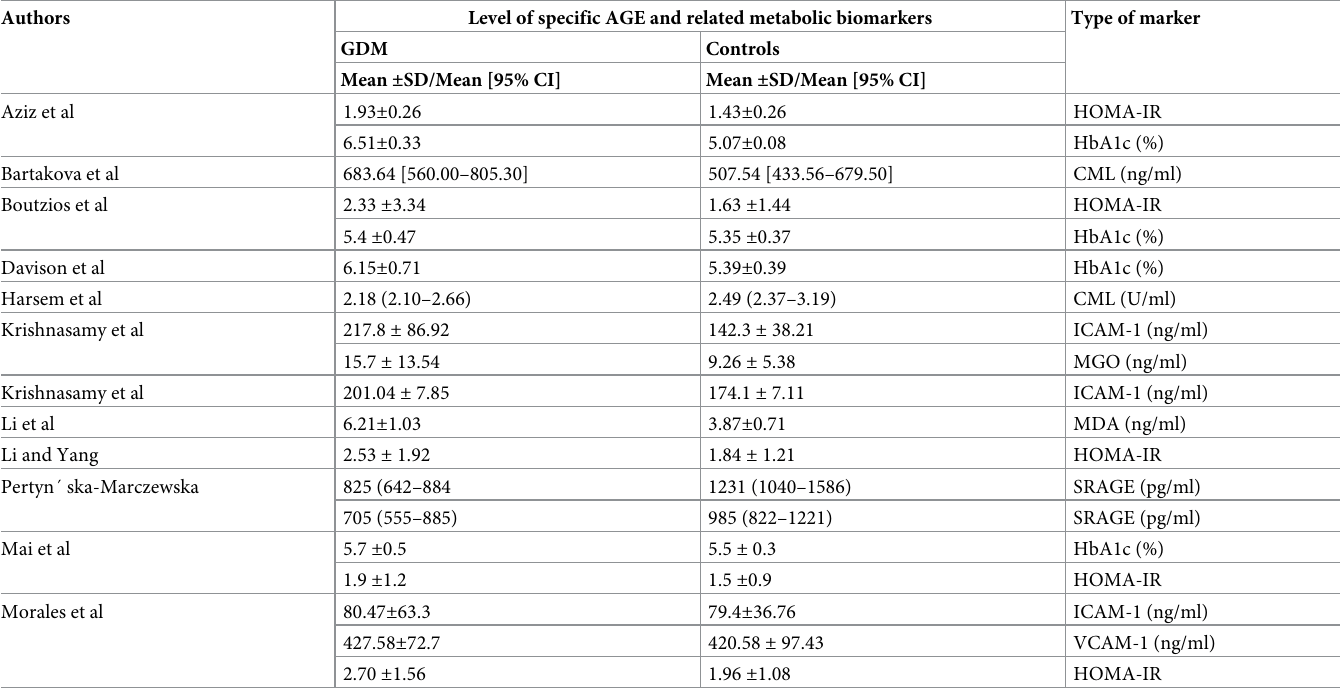
tion of the overall SMD estimate. Nonetheless, meta-regression with the sample size (sum of cases and controls) (regression coefficient (Q) = -0.0092, P = 0.207) and year of publication (Q = 0.0035, P = 0.984) suggested that the covariates had no significant effect on the heteroge- neity between studies. Likewise, the bivariate meta-regression analysis also showed that either of them did not significantly contribute to the heterogeneity (P = 0.65 and P = 0.20 for Table 2. Level of specific AGEs and related metabolic biomarkers implicated for diabetic